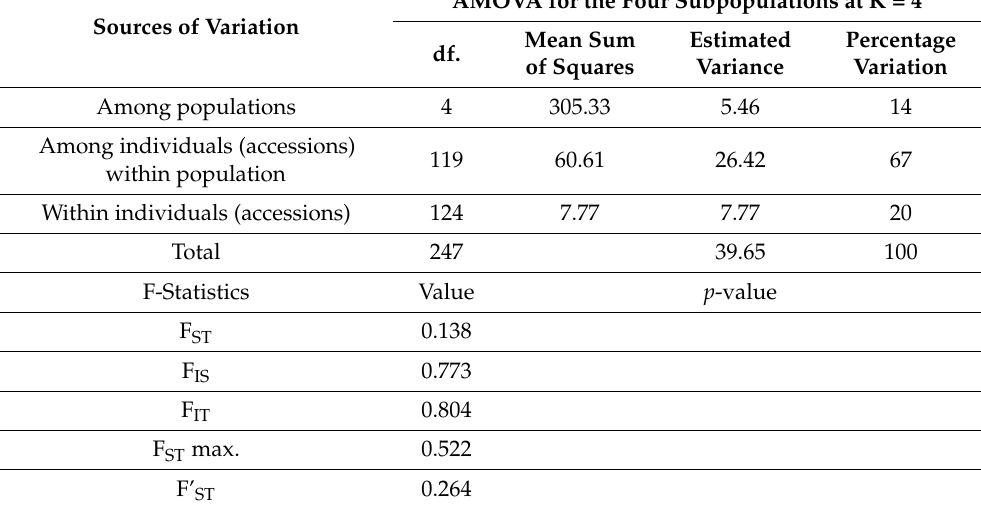
Table 3. Analysis of molecular variance (AMOVA) of the panel population for germination rate and early seedling growth parameters in